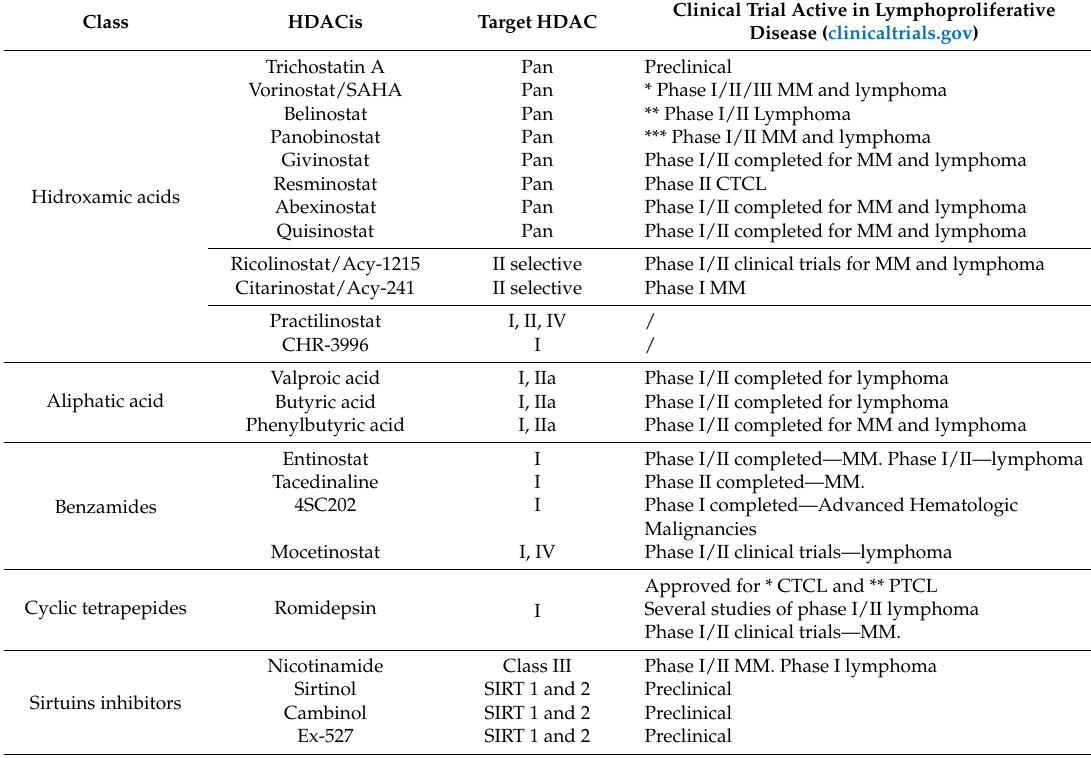
Histone deacetylase inhibitors (pan and selective) in clinical trials of lymphoproliferative